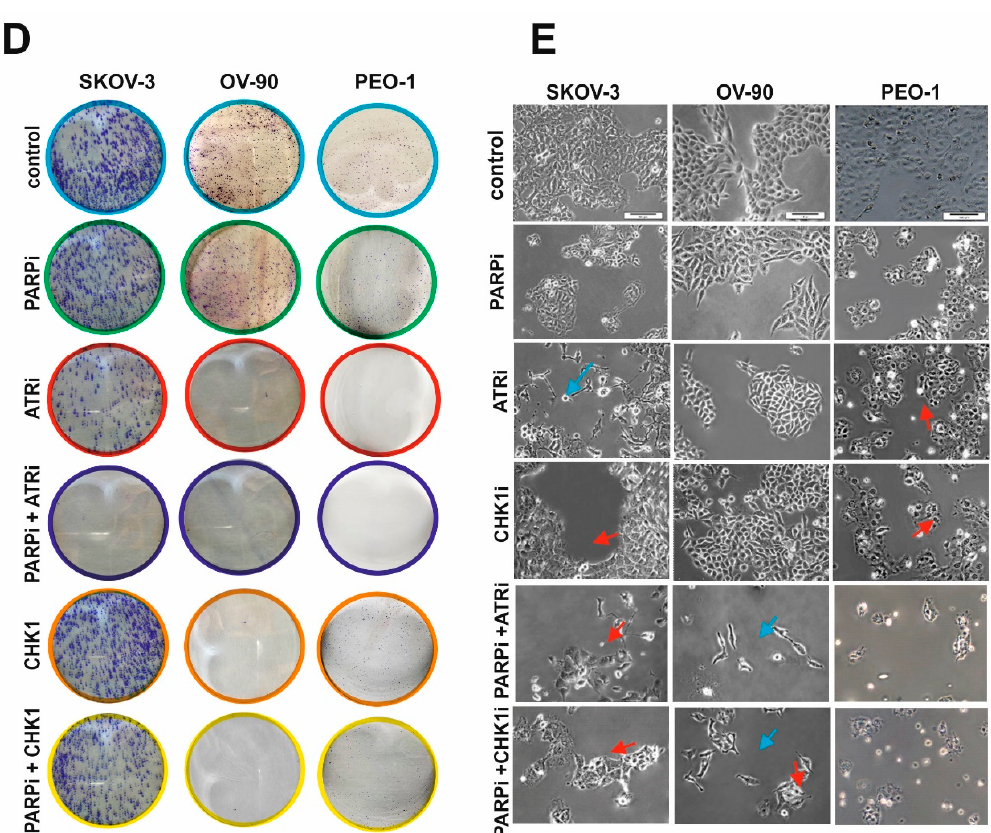
Figure 1. PARPi in combination with CHK1i or ATRi decreased viability more effectively than PARPi monotherapy. ( A ) Cell viability after treatment with PARPi (AZD2281), CHK1i (MK8776), and ATRi (AZD6738) in HR-deficient (PEO-1, BRCA2 MUT ) and HR-proficient (OV-90, SKOV-3, BRCA WT ) cells at increasing concentrations for 5 days was assessed by the MTT assay. ( B ) Structural formulas of PARPi, ATRi, CHKi. ( C , D ) Colony formation assay. Colony formation was evaluated after treatment with PARPi at 0.5 µM in SKOV-3, OV-90, and PEO-1 cells. Cells (200 cells/well) were seeded into six-well plates and incubated with the indicated drug concentrations for 14 days. Colony numbers were counted manually (* p < 0.05). For each sample, the results from three replicates were averaged. PARPi and CHK1i decreased viability to 80.17% and 97.28%, respectively, compared with the control SKOV-3 cells; to 78.33% and 3.63%, respectively, in OV-90; and to 75.35% and 0.25%, respectively, in PEO-1 cells. Combination therapy with PARPi and CHK1i decreased colony formation to 68% in SKOV-3, 2.5% in OV-90, and 22.82% in PEO-1 cells. In all cell lines, drugs used in combination had a synergistic e ff ect compared with single drug administration (SKOV-3, CDI = 0.07; OV-90, CDI = 0.07; PEO-1, CDI = 0.06). Combined PARPi and ATRi treatment decreased colony formation to < 1% compared with PARPi alone and ATRi alone. In all cell lines, the combination of PARPi / ATRi had a synergistic e ff ect compared with single compounds (SKOV-3, CDI = 0.004; OV-90, CDI = 0.03; PEO-1, CDI = 0.01). All data correspond to three biological assays and were graphed as means ± SD. ( E ) The morphology of SKOV-3, OV-90, and PEO-1 cells treated for 24 h with ATRi, CHK1i, and their combination with olaparib (0.5 µ M concentration of each single drug) was examined under an inverted microscope (Olympus IX70, Japan) (scale bar = 100 µ m). The cells were elongated and thin (blue arrows) or enlarged (red arrows). * Statistically significant changes between samples incubated with the compound compared with control cells ( p < 0.05). + Statistically significant changes between samples incubated with PARPi and combination treatments (PARPi / ATRi; PARPi / CHK1i) ( p < 0.05). # Statistically significant di ff erences between samples incubated with ATRi or CHKi and their combination (PARPi / ATRi; PARPi / CHK1i) ( p <